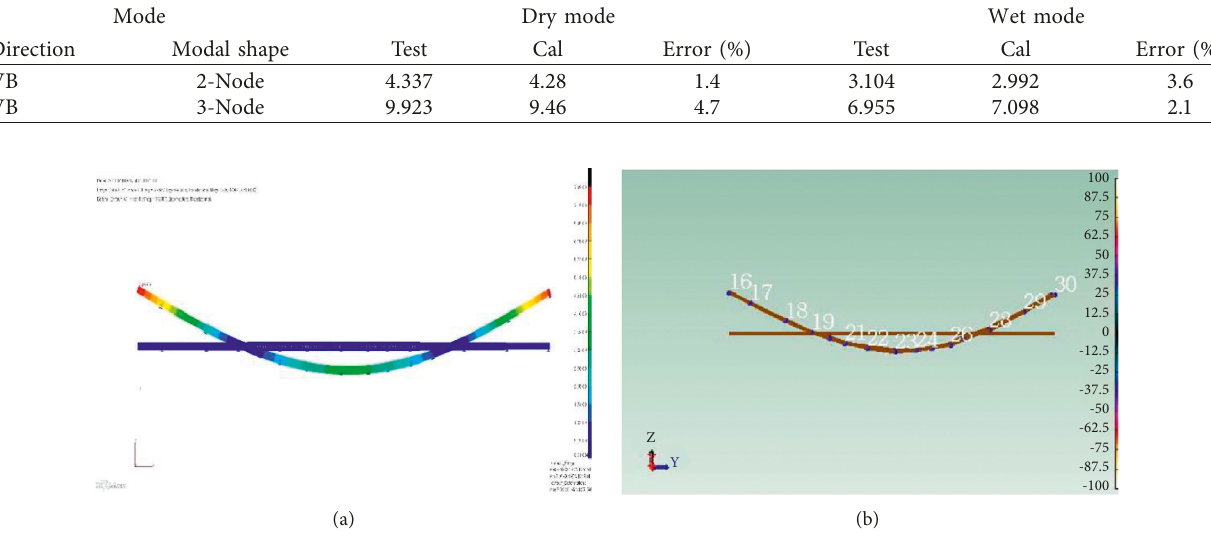
Figure 12: Vertical bending modal shape (2 nodes), full loading condition. (a) Numerical prediction. (b) Measurement